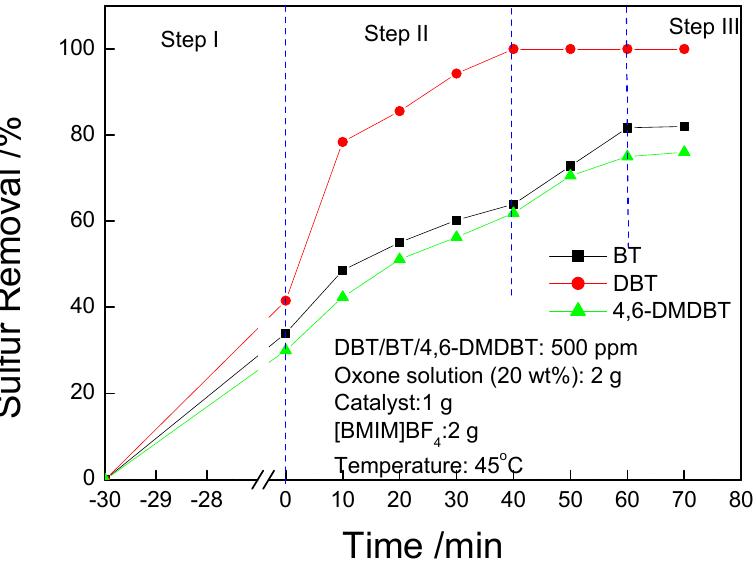
Figure 9. Effect of different sulfur organic compounds.